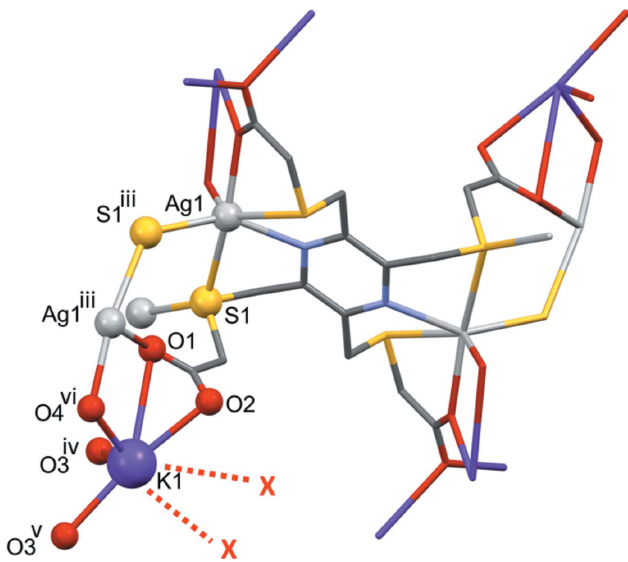
Figure 3 A view of the environment of the potassium cation in compound I . [ X (red) regions of disordered water molecules; symmetry codes: (iii) (cid:4) x , y (cid:4) 1 , (cid:4) z + 1 ; (iv) (cid:4) x + 1, (cid:4) y + 1, (cid:4) z + 1; (v) x , (cid:4) y + 1 2 2 z (cid:4)